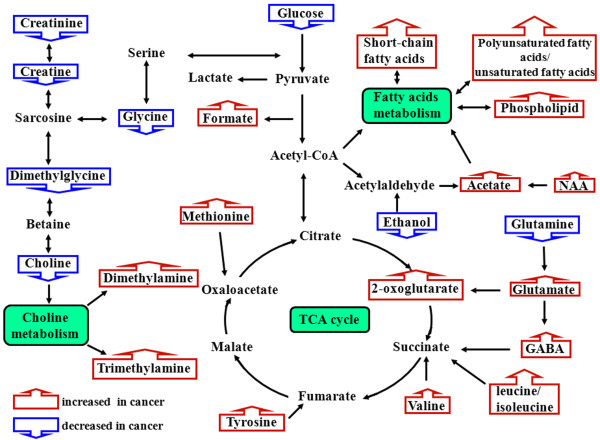
Altered metabolic pathways for the most relevant distinguishing metabolites between esophageal cancers and normal mucosae. Blue boxes indicated metabolites that were up-regulated in esophageal cancers, while red boxes indicated metabolites that were down-regulated.